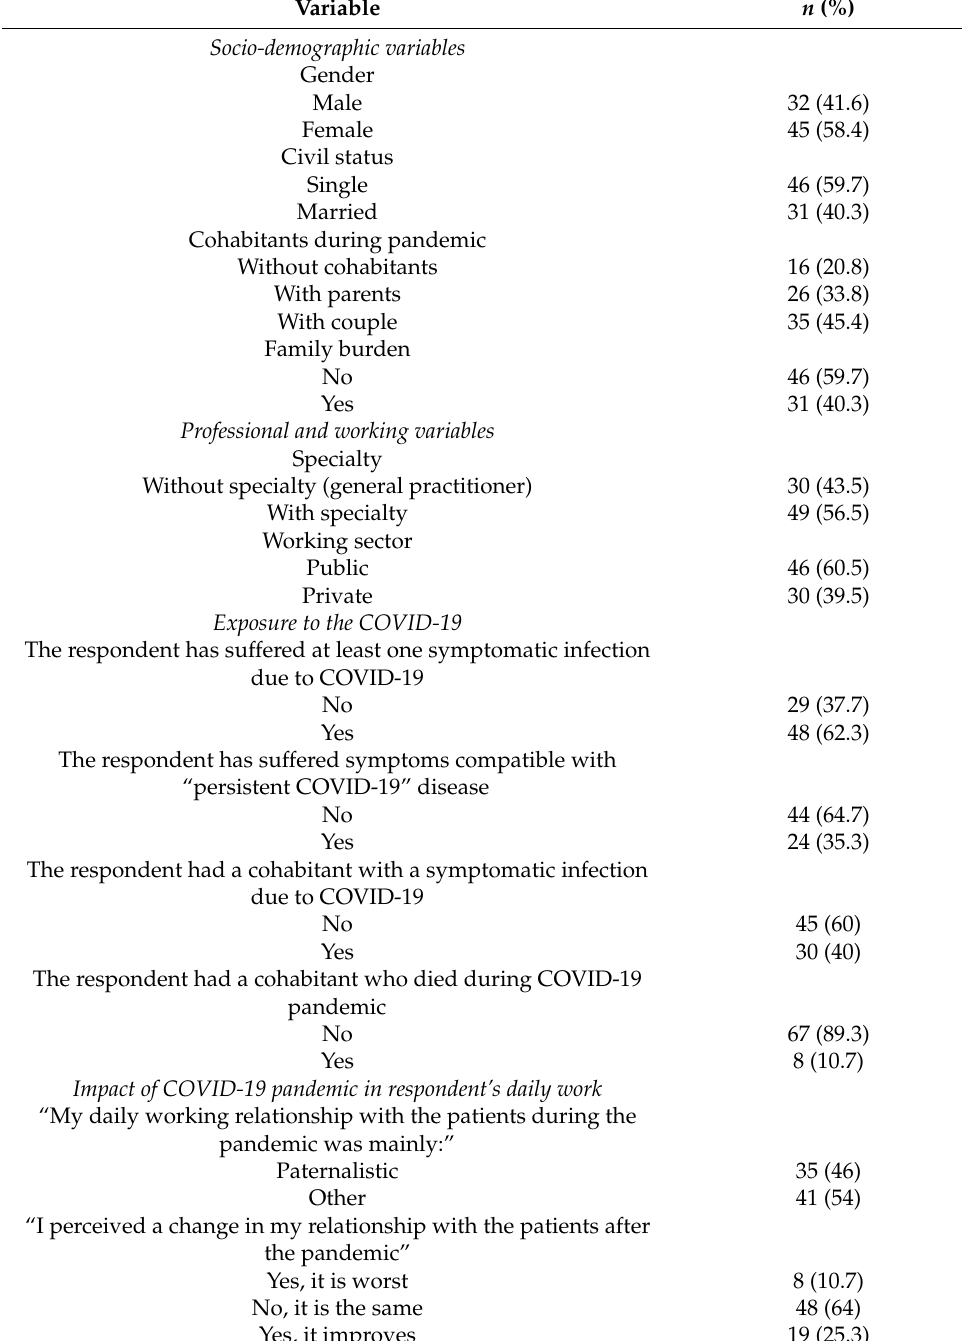
Table 1. Descriptive analysis of socio-demographic, professional, and working variables, and vari- ables associated with the exposure to COVID-19 ( n =